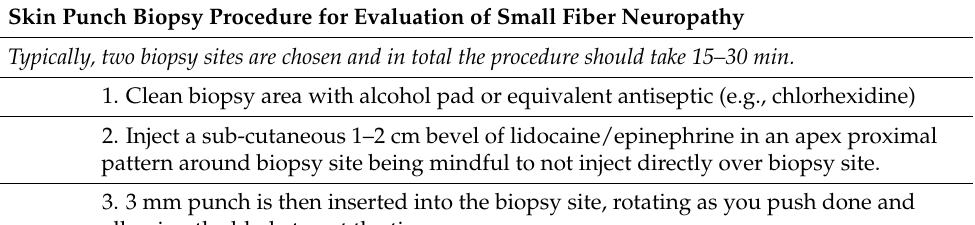
Table 2. Clinical procedure for skin punch biopsy for use in evaluation of IENFD. Skin Punch Biopsy Procedure for Evaluation of Small Fiber Neuropathy Typically, two biopsy sites are chosen and in total the procedure should take 15–30